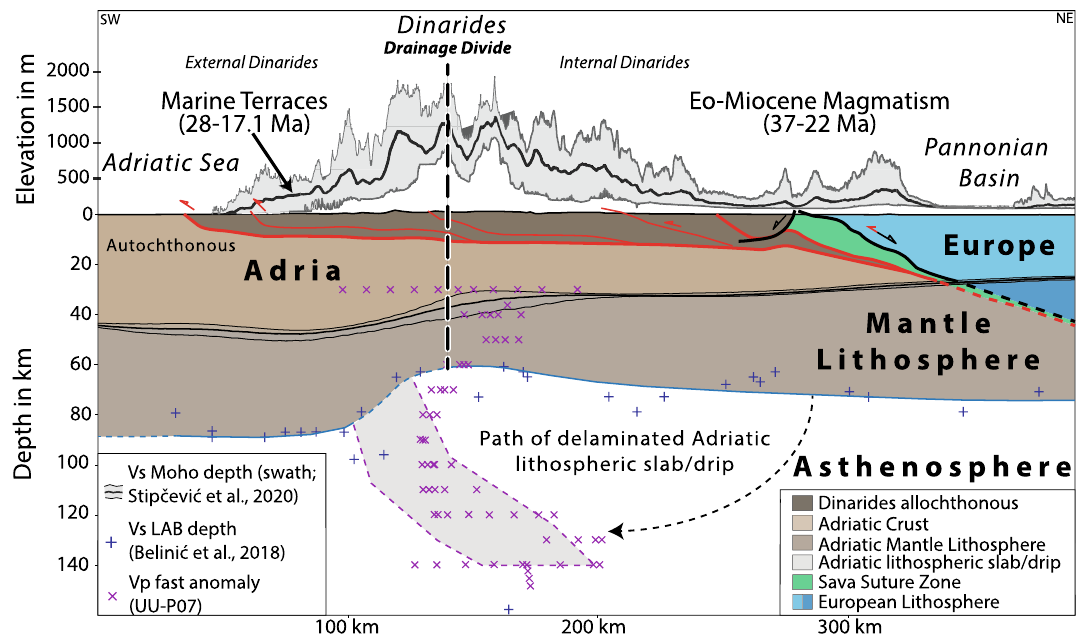
Figure 6. Lithosphere-scale cross-section across the Dinarides fold and thrust belt. Topographic and Moho depth swath profiles (50 km width) along the section trace (location Fig. 1b). Main detachments of mainly Paleogene nappe stacking (red) and younger partly reactivated extensional detachments in black 16 . The LAB depth is projected into the section trace (location: Fig. 1b). The thinnest lithospheric part corresponds to the drainage divide. The fast P-wave tomographic anomaly is interpreted as a remnant of the “peeled-off” Adriatic